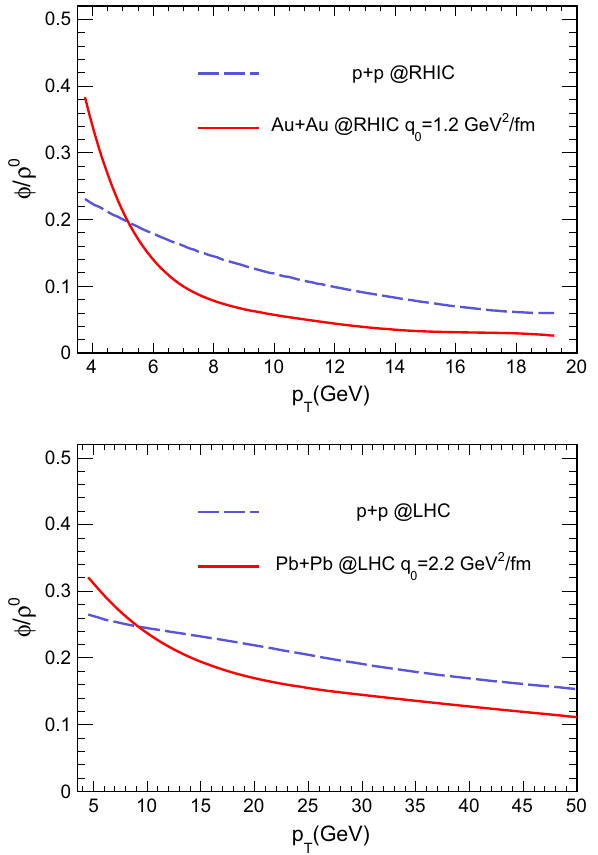
Fig. 8 Top φ/ρ 0 as a function of p T in p + p and Au + Au collisions at the RHIC. Bottom φ/ρ 0 as a function of p T in p + p and Pb + Pb collisions at the